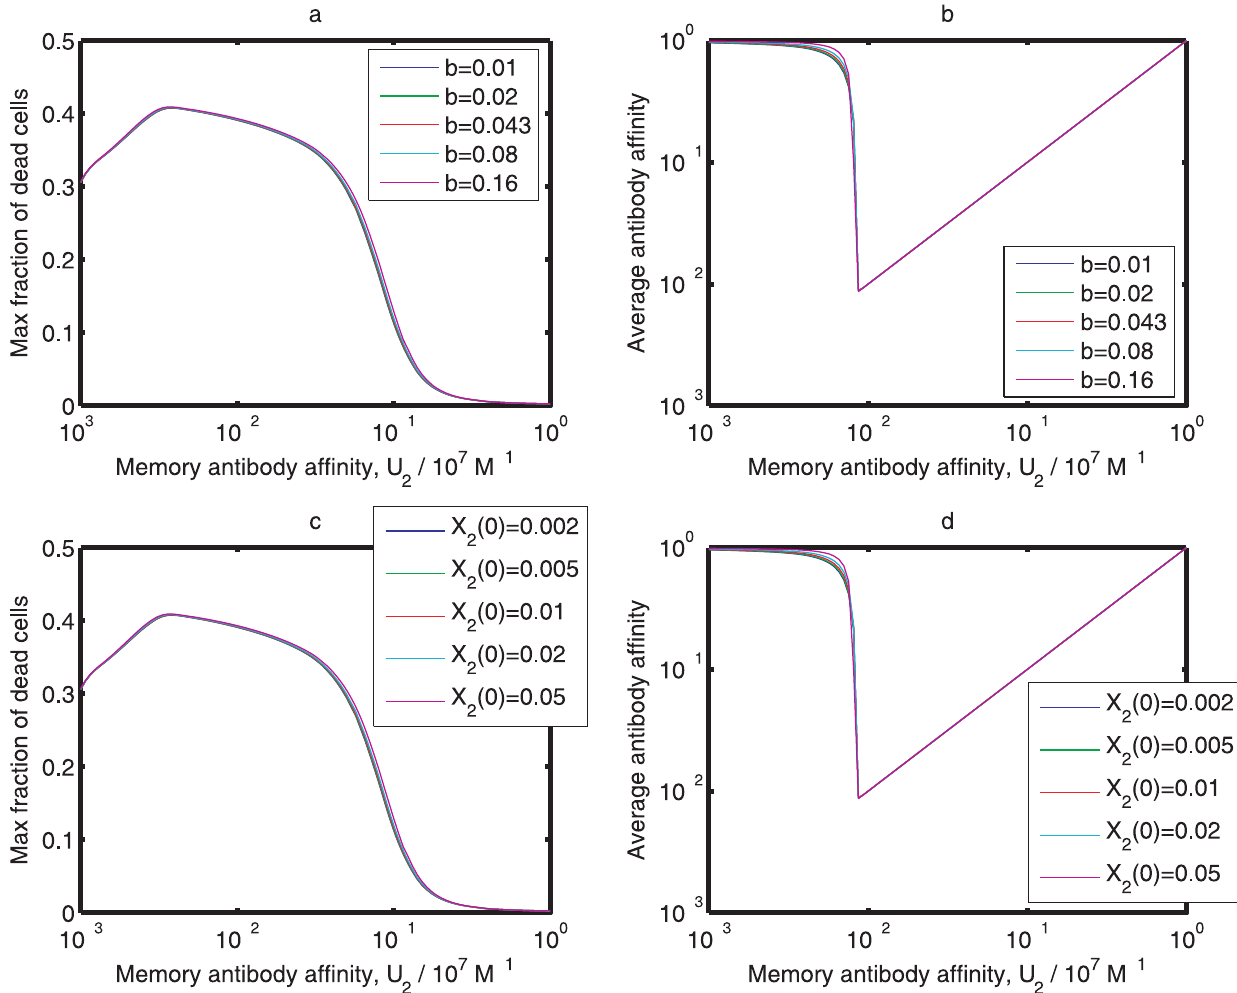
Figure 7. Sensitivity analysis of parameters b and X 2 0 ð Þ . (a) and (b) The maximum percentages of dead cells and the average antibody affinities at different values of b . (c) and (d) The maximum percentages of dead cells and the average antibody affinities at different values of X 2 0 ð Þ . Initial conditions and parameters other than b and X 2 0 ð Þ are the same as those in Figure 3.